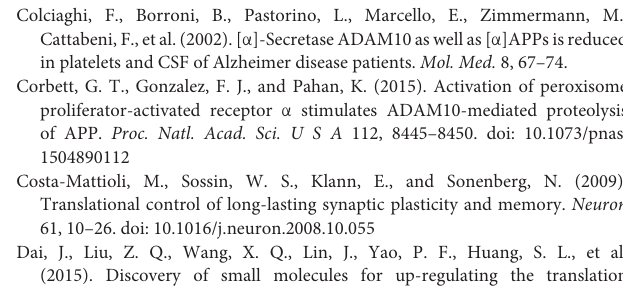
FIGURE S1 | Chemical structure of cosmosiin. FIGURE S2 | A full blot of ADAM10. Representative Western blots of ADAM10 in a full membrane. Proteins were extracted from SH-SY5Y cells treated with vehicle DMSO (1:10000) or 5 µ M cosmosiin for 36 h, and were probed by ADAM10 antibody (ab1997; 1:1000). FIGURE S3 | Sequence alignment between human and mouse ADAM10 5’UTRs. A MegAlign program (DNAstar, Madison, WI, USA) was used to perform alignment analysis between human ADAM10 5’UTR (NCBI Reference Sequence: NM_001110.3, GI:114657268) and mouse ADAM10 5’UTR (NCBI